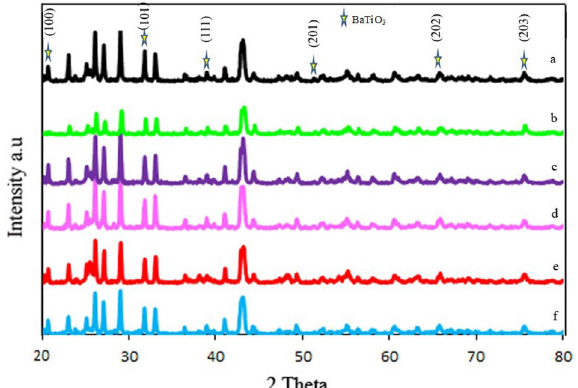
Figure 1. XRD pattern of ( a ) BaSO 4 –BaTiO 3 , ( b ) Cu–BaSO 4 –BaTiO 3 , ( c ) Fe–BaSO 4 –BaTiO 3 , ( d ) S– BaSO 4 – BaTiO